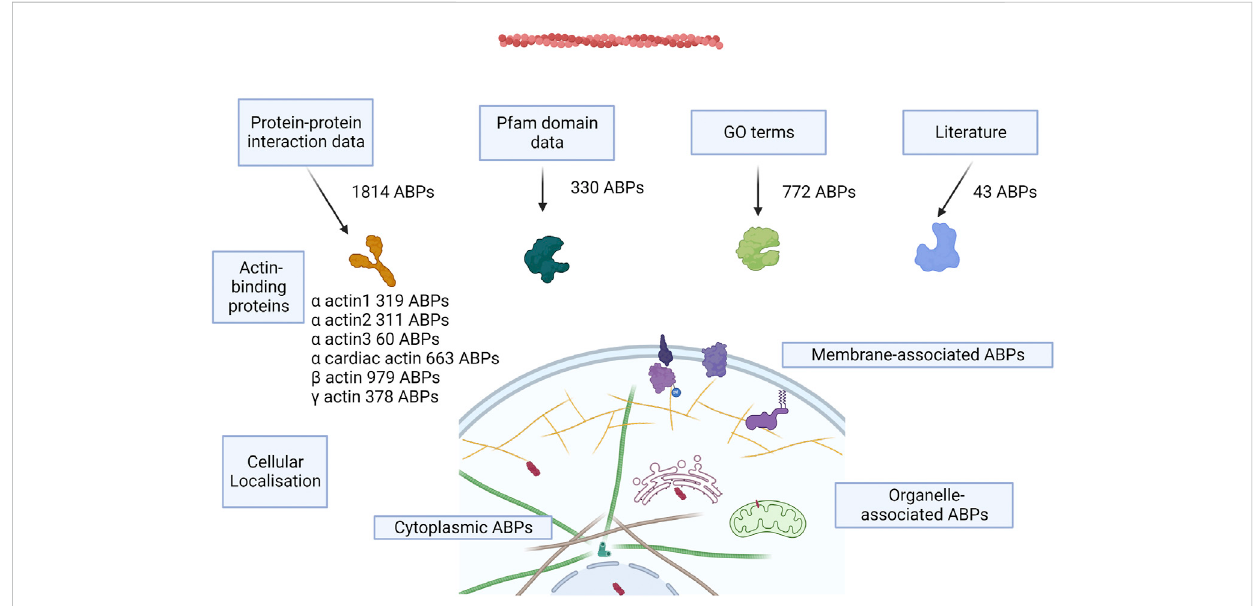
FIGURE 2 Concept fi gure. The fi gure shows a schematic of the approaches to annotate AAPs from the human proteome and the number of AAPs identi fi ed fromeachmethod.Mostoftheproteinsarepresentinthecytoplasm,someoftheproteinsassociatewiththemembrane,andfewproteinsarepresentin organelles like the nucleus, mitochondria, ER, and the Golgi